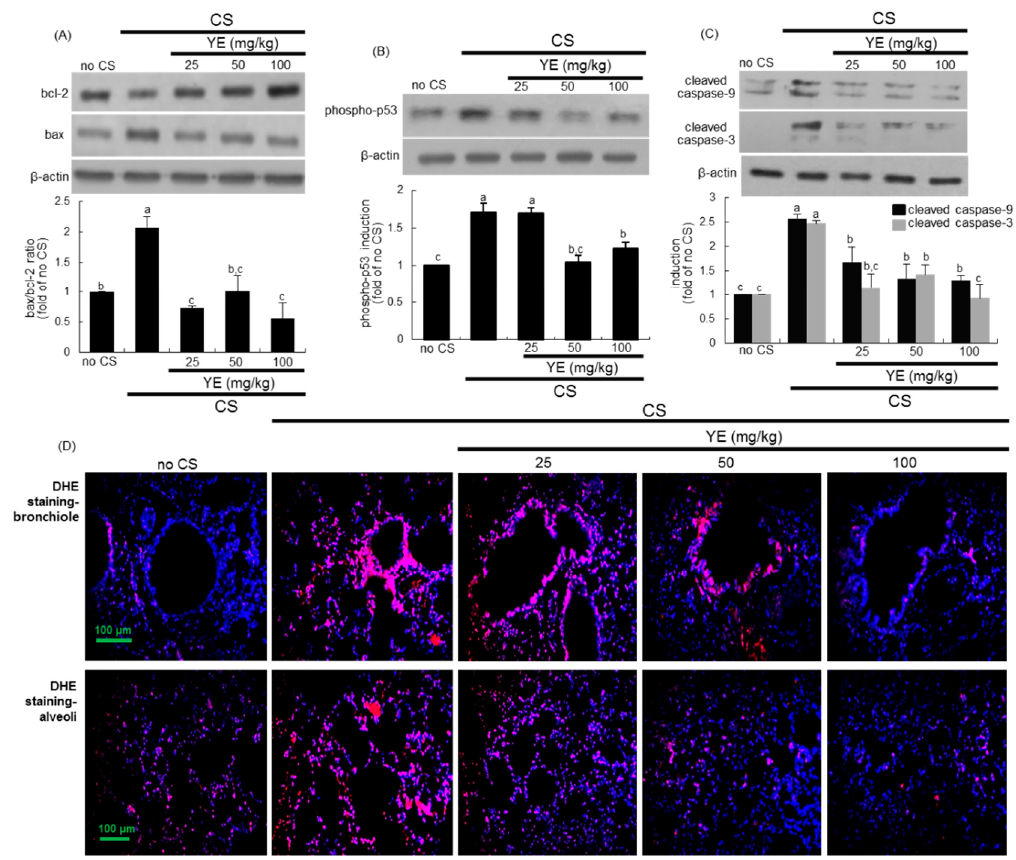
Figure 4. Inhibition of apoptotic lung injury and reactive oxygen species (ROS) production by 25–100 mg/kg yeast extracts (YE) in cigarette smoke (CS)-challenged mouse lungs. Tissue extracts were subject to Western blot with a primary antibody against bcl-2, bax, phospho-p53, cleaved caspase-9, or cleaved caspase-3 ( A – C ). β -Actin protein was used as an internal control. The bar graphs (mean ± SEM, n = 3) represent quantitative results of the upper bands obtained from a densitometer. Values in respective bar graphs not sharing a same small letter indicate a significant difference at p < 0.05. Dihydroethidium (DHE) staining showing pulmonary ROS production ( D ). Tissue sections of small airways and alveoli were stained with DHE, and nuclear staining was done with DAPI (blue). Each photograph is representative of four mice. Scale bars = 100 µm.